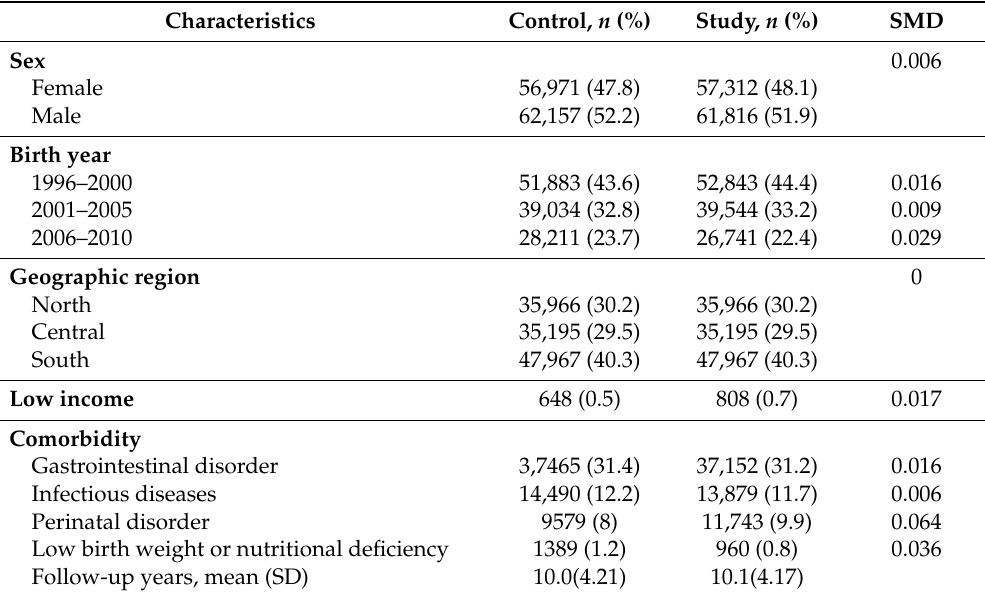
Table 2. Baseline characteristics in the study and control